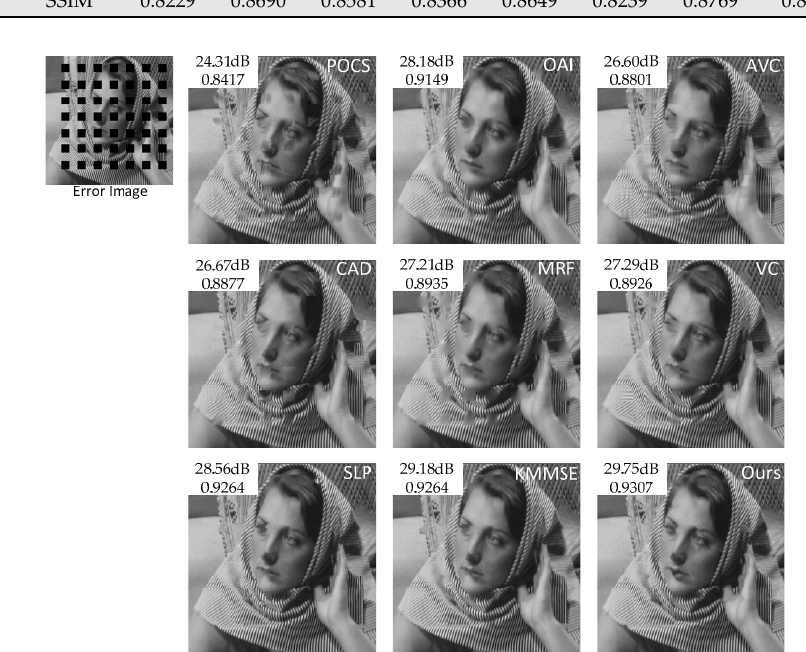
Figure 20. Subjective comparison of different EC algorithms on the Butterfly image with 16 × 16 consecutive block loss. The corresponding PSNR and SSIM values are also shown in the upper left corner.